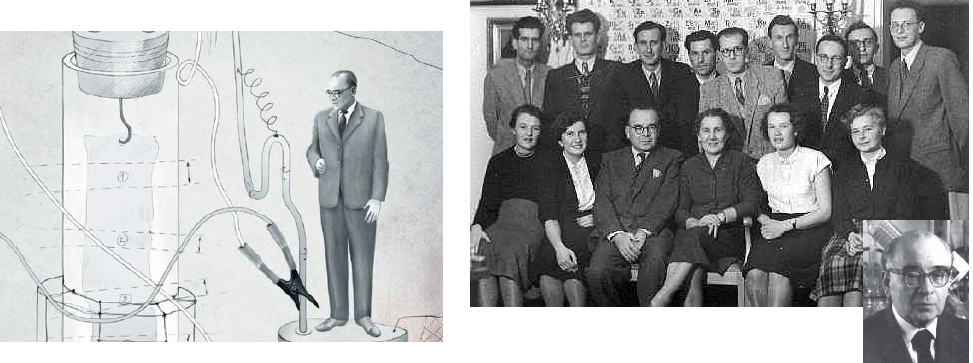
Figure 4. Prof. W. Kemula (1902–1985) together with students of the Faculty of Chemistry, University of Warsaw and the concept of chromatpolarography.